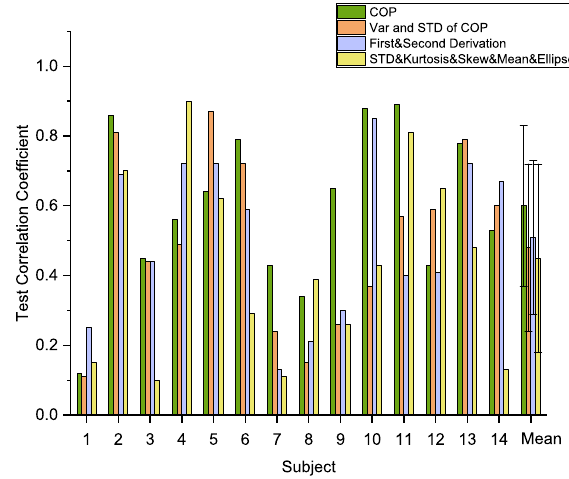
Figure 5. Correlation results with different COP features. 4.2. Performance of Fatigue Estimation with Only IMU Data vs. Only FP Data The selected COP and IMU feature sets were applied to train the random forest and CNN models separately for three different exercises. Then, the selected and trained models after cross-validation were fed with the corresponding test set. In Figure 6, the test results of each participant with different models are compared for the squat, high knee jack, and corkscrew toe-touch exercises, respectively. Examples of the regression relationships between the predicted and true fatigue levels are shown in Figure 7 (Participants 2, 5, and 8 based on force plate data for the squat exercise).